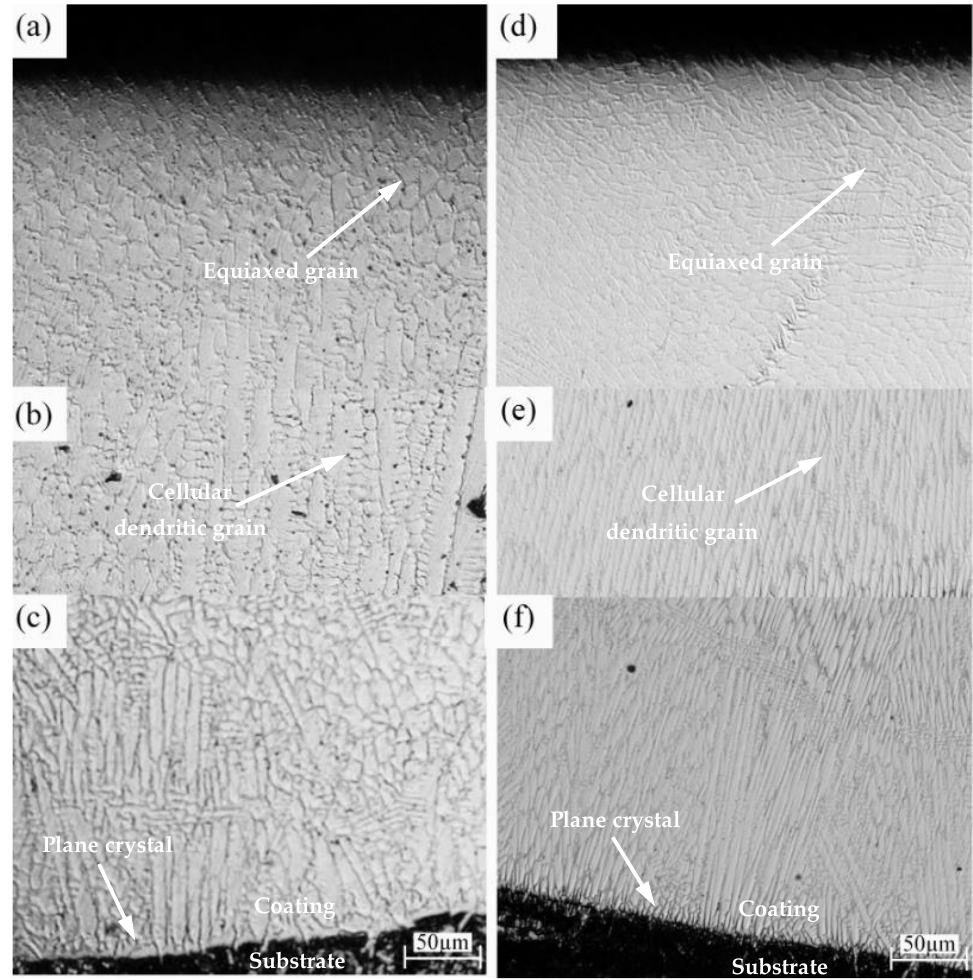
Figure7 Figure 7. The metallographic images of the cross-sections of coating samples: ( a – c ) for LC(FeCoNiCr);